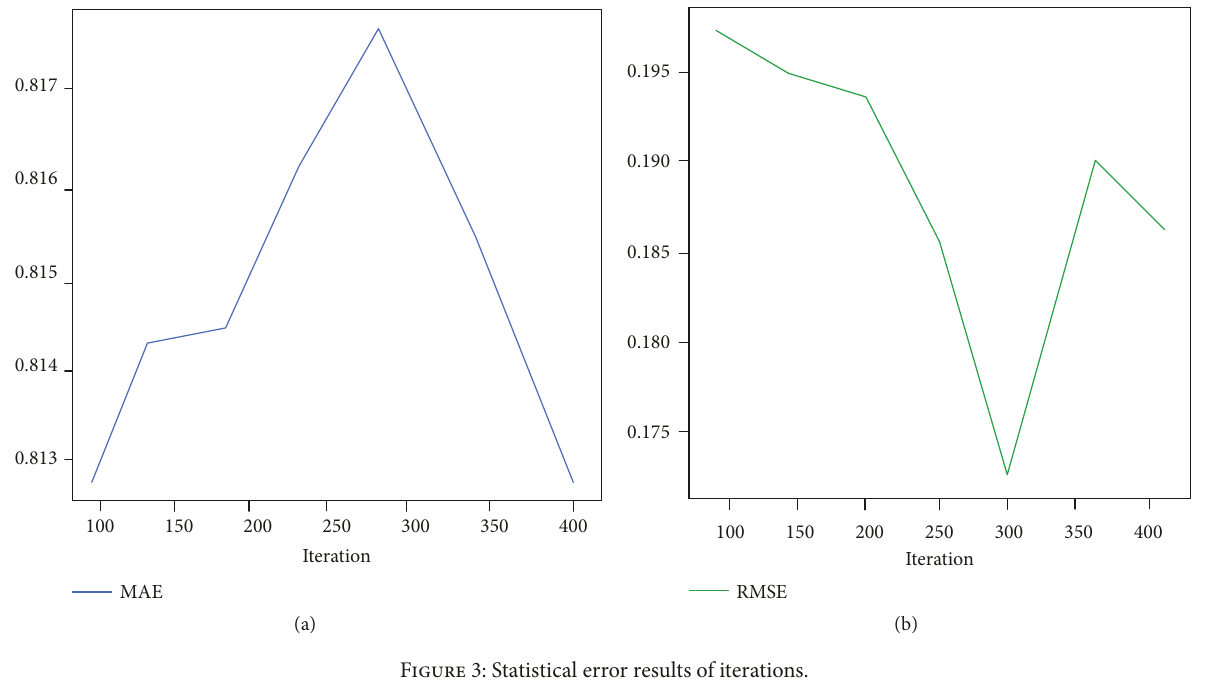
Figure 3: Statistical error results of iterations.